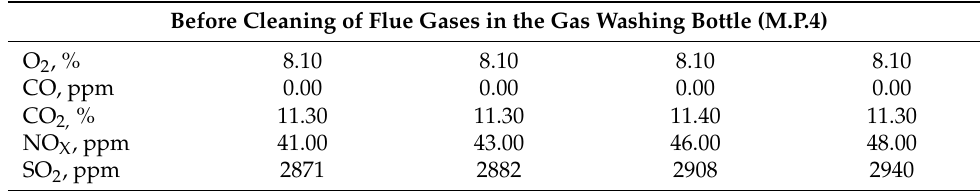
Table 3. Emission parameters values before and after flue gases